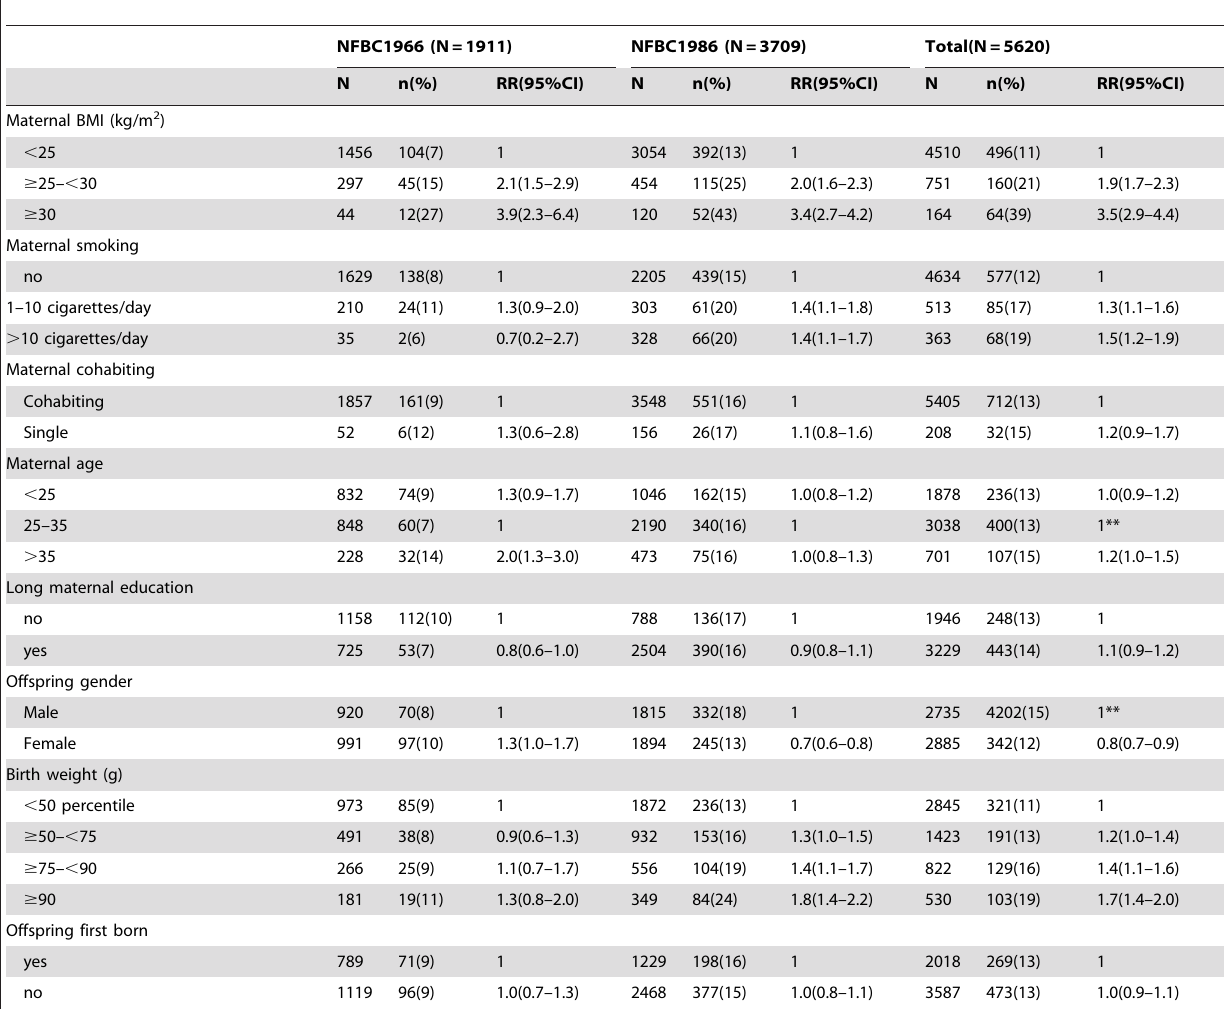
Table 5. Relative risk of overweight at the age of 15 years according to the IOTF associated with pre-and perinatal risk indicators in the NFBC1966 and the NFBC1986.